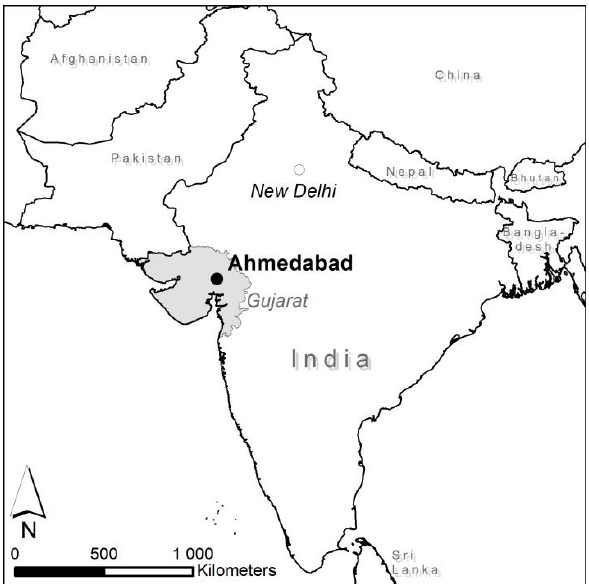
Figure 1: Location of Ahmedabad